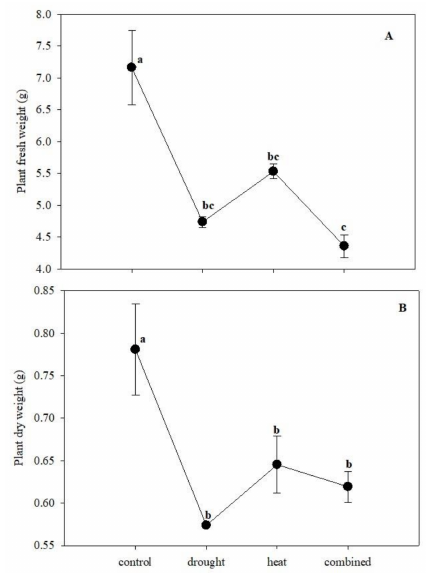
Figure 1. The maize growth in terms of fresh ( A ) and dry weight ( B ) in the presence of single (drought and heat stress) and combined stress. The bars represented the error standard (N = 4). Different letters indicated significant difference among the treatments ( p < 0.05; Tukey’s